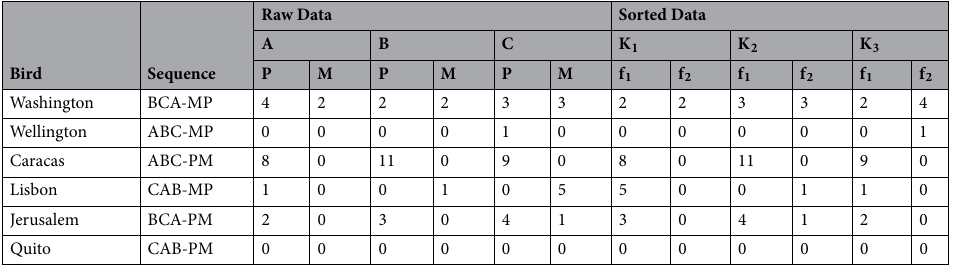
days 1, 3, 5, 7, 9 and on the hypothetical trial on day 11, and (ii) f2 corresponded to the food received on experi- ence days 2, 4, 6, 8 and on the hypothetical trial on days 10 and 12. To determine the factors that best explain the caching behaviour, the number of items n bfc of food type f cached by bird b in compartment c were treated as random variables drawn for each bird b from multinomial distributions with 6 categories ( 2 × 3 for each food–compartment combination). We compared 13 different possibilities, i.e., models, to set the rates r bfc of the multinomial distributions. Models with rates independent of food type were characterised by equal rates r bf 1 c = r bf 2 c for both food types, whereas in models with food type dependent rates, both r bf 1 c and r bf 2 c were treated as independent parameters. Similarly, models with rates inde- pendent of bird identity had equal rates for all birds r b 1 fc = r b 2 fc = · · · = r b 6 fc and models with rates independent of compartment had equal rates for all three compartments r bfc 1 = r bfc 2 = r bfc 3 . Each model was characterised by the triple (food type dependence, bird identity dependence, compartment dependence), yielding 8 = 2 3 different models. Effectively, there are only 7 different models, because bird dependence does not matter for compartment and food type independent models, where the rates are equal to 1/6 for each food type and compartment. We used uniform conjugate priors for the Bayesian model comparison. The Future Planning Hypotheses and the Compensatory Caching Hypothesis were formalised with constraints on the prior rates. For Prediction 1 of the Future Planning Hypothesis we used a prior with r bf 1 K 1 ≥ r bfc for all f = f 1 and c = K 1 . For Prediction 2 of the